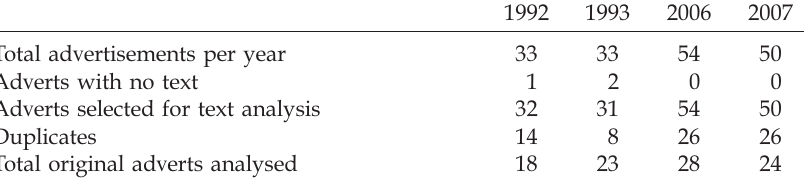
Table 1. Number of ad v ertisements per